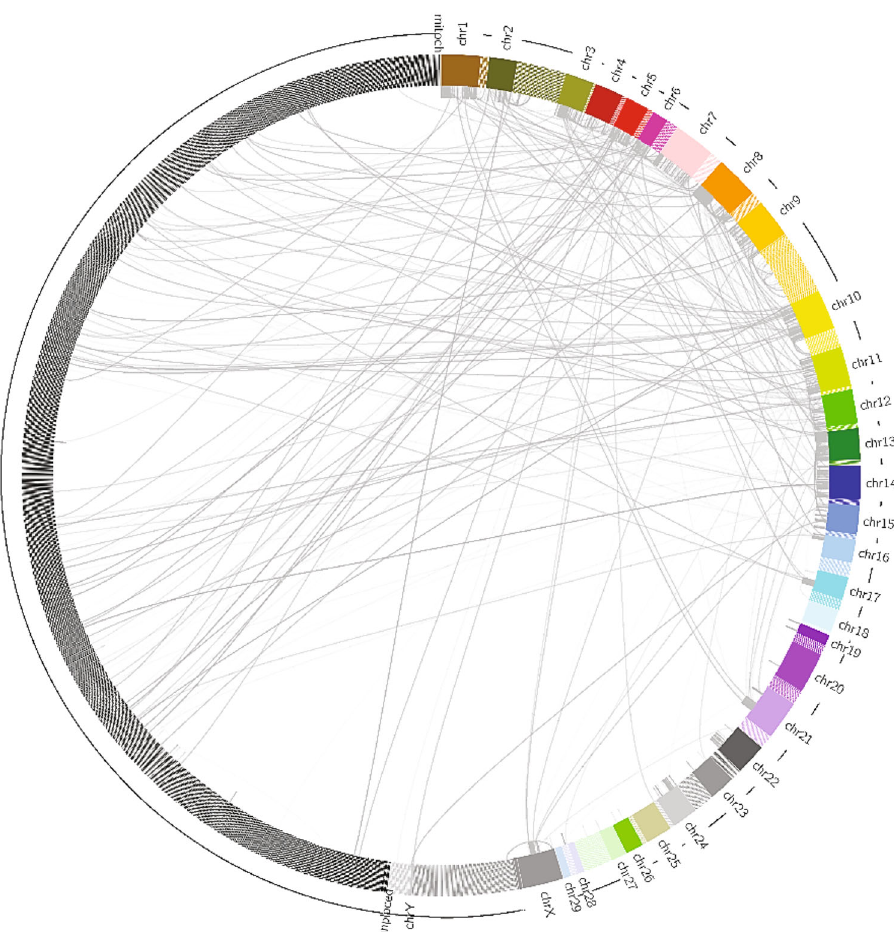
Fig. 4 Circos plot of Manta called large-scale variants. The outer circle represents the African Green Monkey genome including its unplaced scaffolds (left dark gray) to highlight the interchromosomal translocations in the Vero genome relative to the African Green Monkey